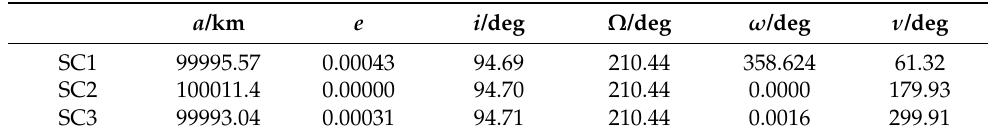
Table 1. The nominal orbital elements in the EarthMJ2000Ec coordinate at the epoch 22 May 2034